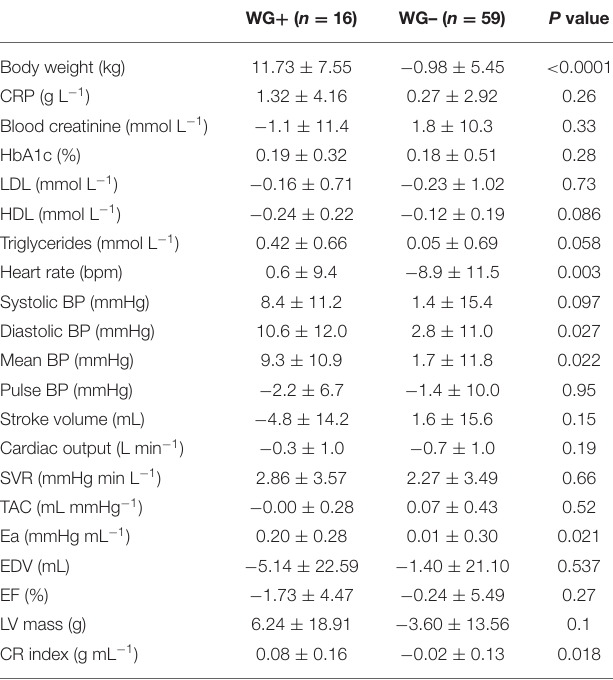
TABLE 3 | Comparison between the obese subjects exhibiting significant weight gain (WG + ) and those without weight gain (WG–), of the parameter differences calculated between follow-up and baseline.